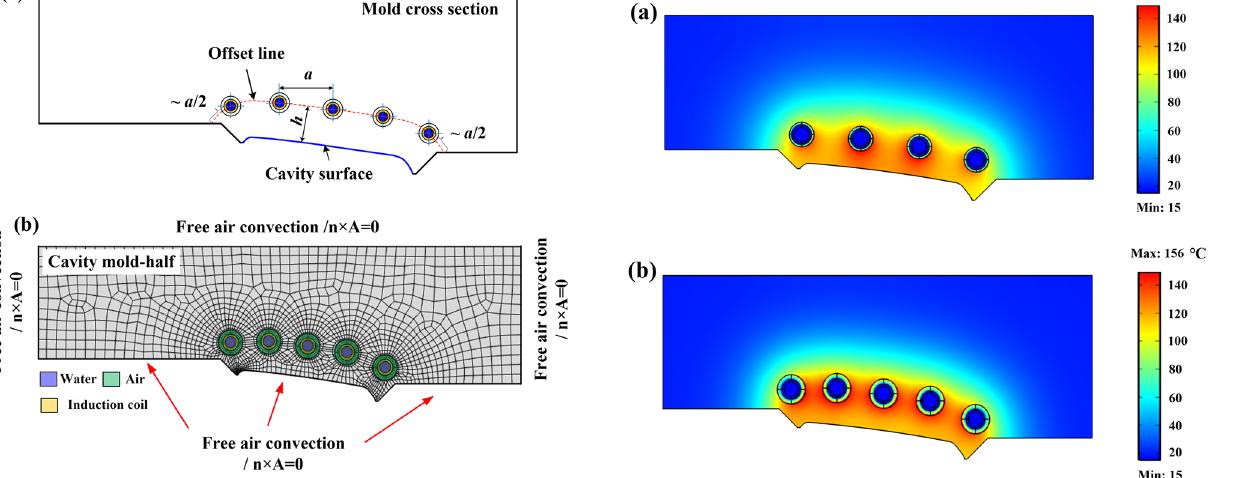
Fig. 10 Temperature field contours on the analyzed cross section of cavity mold half with ( a ) initial and ( b ) optimal design cases